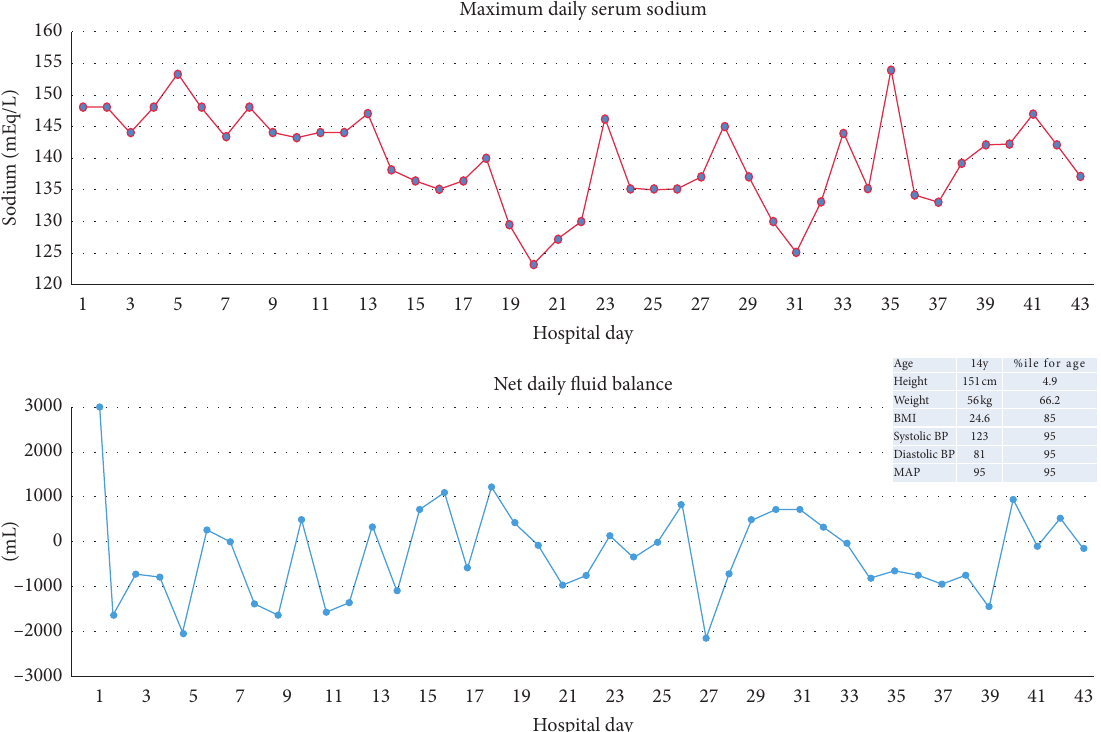
Figure 2: Daily net fluid balance and serum sodium values during the acute period of